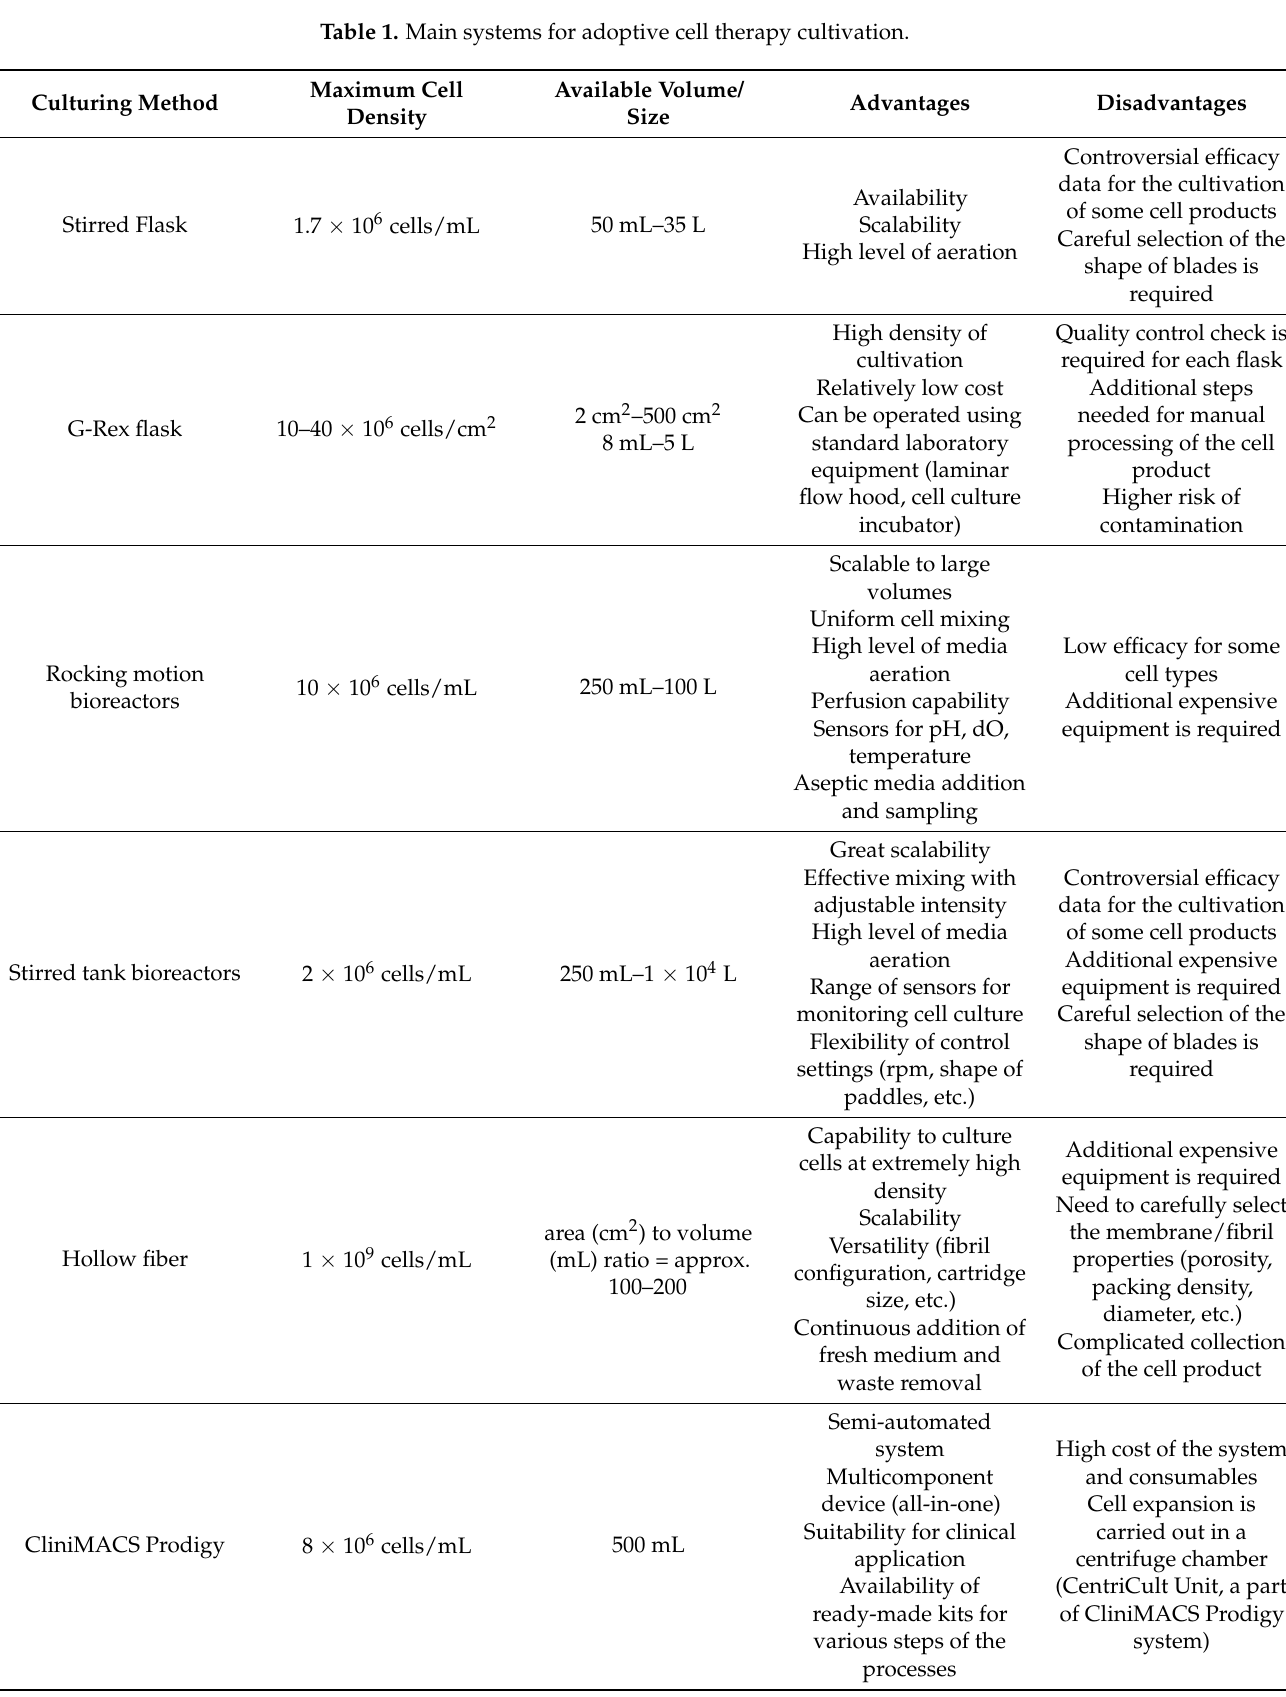
Table 1. Main systems for adoptive cell therapy